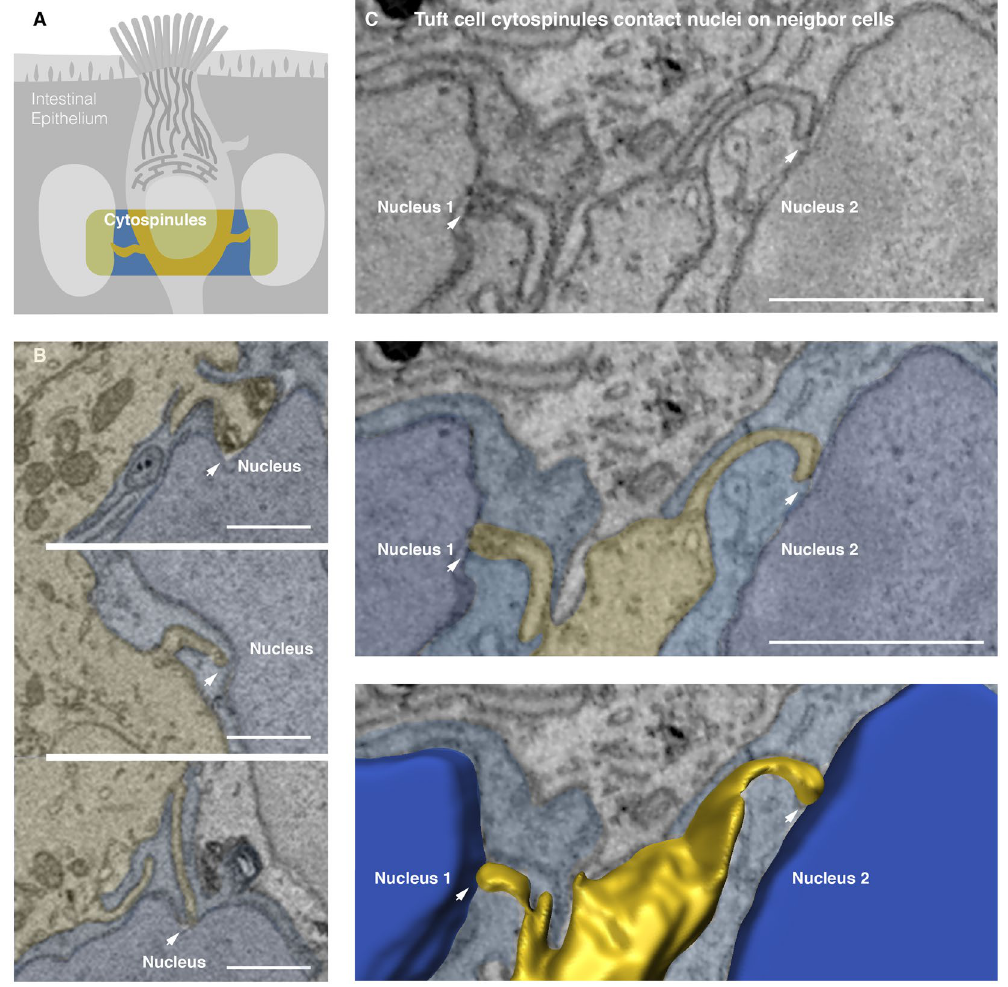
Figure 3. Tuft cell cytospinules contact nuclei of neighbor cells. ( A ) An overview of tuft cell cytospinules. These lateral cytoplasmic projections of tuft cells penetrate the cytoplasm and contact the nucleus of neighboring epithelial cells. ( B ) Examples of cytospinules (arrows) projecting from a tuft cell into the nuclei of neighboring cells. ( C ) Two cytospinules extend from one tuft cell to contact the nuclei of two different epithelial cells. Points of contact are within the dashed yellow circles. The nuclear membrane often invaginates the cytospinule and the point of contact is dark and electron dense. ( D ) Volume rendering of the cells from panel B shows tuft cytospinules contacting the nuclei of adjacent cells. The cytospinules extend for several microns and their full anatomy and connectivity can only be observed by volume rendering. Bars = 1 µ